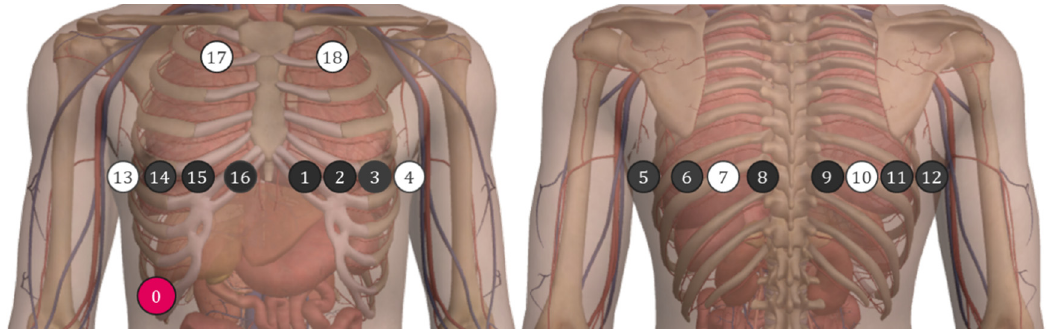
Figure 5. Sensor positions on the chest.